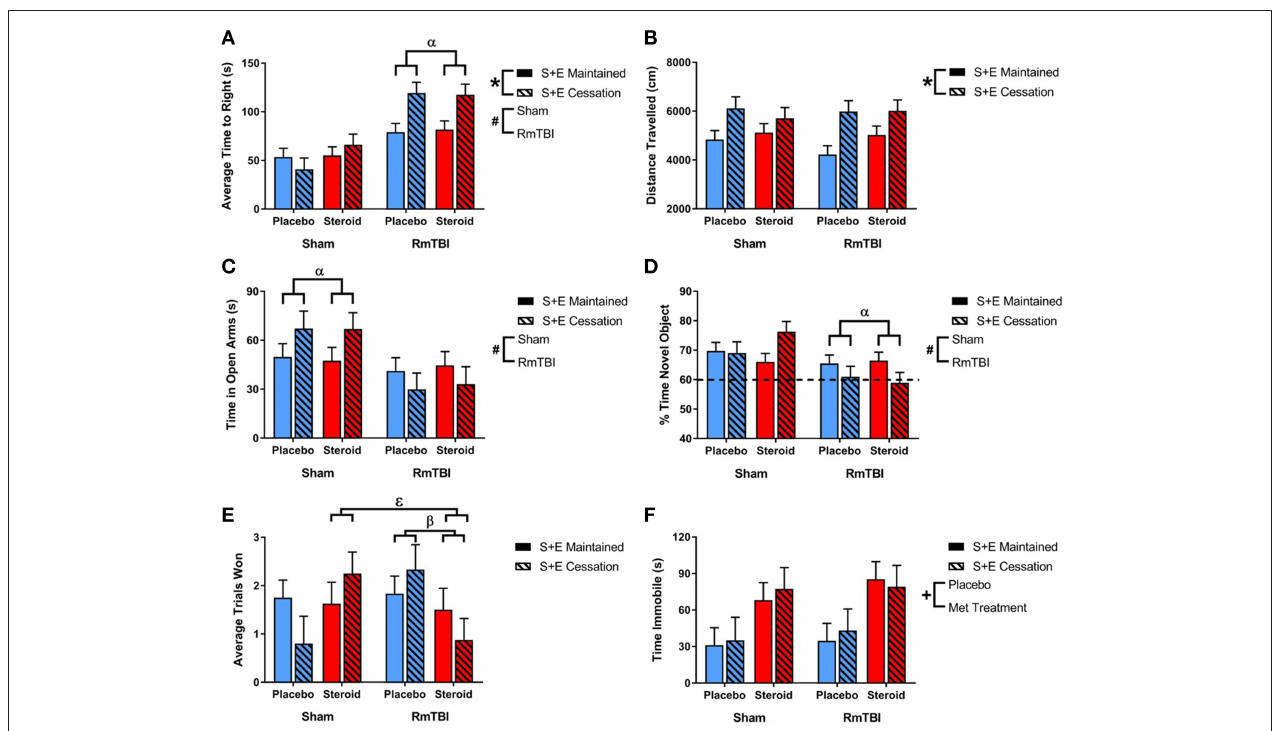
FIGURE 1 | Bar graphs displaying outcomes from behavioral test battery for all groups. Means ± standard error are displayed where *main effect for SEC, # main effect of RmTBI, + main effect of Met treatment, α significant RmTBI by SEC interaction, β significant Met treatment by RmTBI interaction, and ε significant Met treatment by RmTBI by SEC interaction p ≤ 0.05. (A) Displays the average time-to-right after sham injury or RmTBI. Post hoc analysis demonstrated that the Injury × SEC interaction was driven by the animals in the RmTBI group, whereby injured animals that experienced cessation of AAS and exercise exhibited increased loss of consciousness, p < 0.01. (B) Displays the mean distance traveled in the open field test. (C) Displays the average time spent in the open arms of the elevated plus maze. Post hoc analysis of time in open arms of the EPM demonstrated that the Injury × SEC interaction was driven by the sham group, where animals that were exposed to sham injuries and experienced cessation of AAS and exercise displayed reduced anxiety-like behavior and increased time in the open arms of the EPM, p = 0.05. (D) Displays the % of time spent with a novel object in the NCM task. Post-hoc analysis showed that the Injury × SEC interaction was driven by the RmTBI animals, whereby injured animals that experienced cessation of AAS and exercise exhibited worse performance on the NCM task than injured animals that maintained AAS and exercise treatment, p < 0.01. The hatched line indicates the % of expected time the rat will spend investigating the novel object. (E) Displays the average trials won out of 3 possible trials in the dominance tube test. Post hoc analysis demonstrated that the Met Treatment by Injury interaction was driven by the RmTBI group. Animals that experienced RmTBI and placebo were more aggressive than RmTBI animals consuming AAS, p = 0.05. In addition, Post hoc analyses of the 3-way interaction between Met Treatment, Injury, and SEC found this interaction to be driven by animals in the S + E cessation group, whereby dominance/aggression increased in sham animals who experienced cessation of AAS and exercise ( p = 0.05), but decreased in RmTBI animals that experienced cessation of AAS and exercise ( p = 0.03). (F) Displays the mean time spent immobile in the forced swim test. RmTBI, repetitive mild traumatic brain injury; S + E, steroid and exercise; NCM, novel context